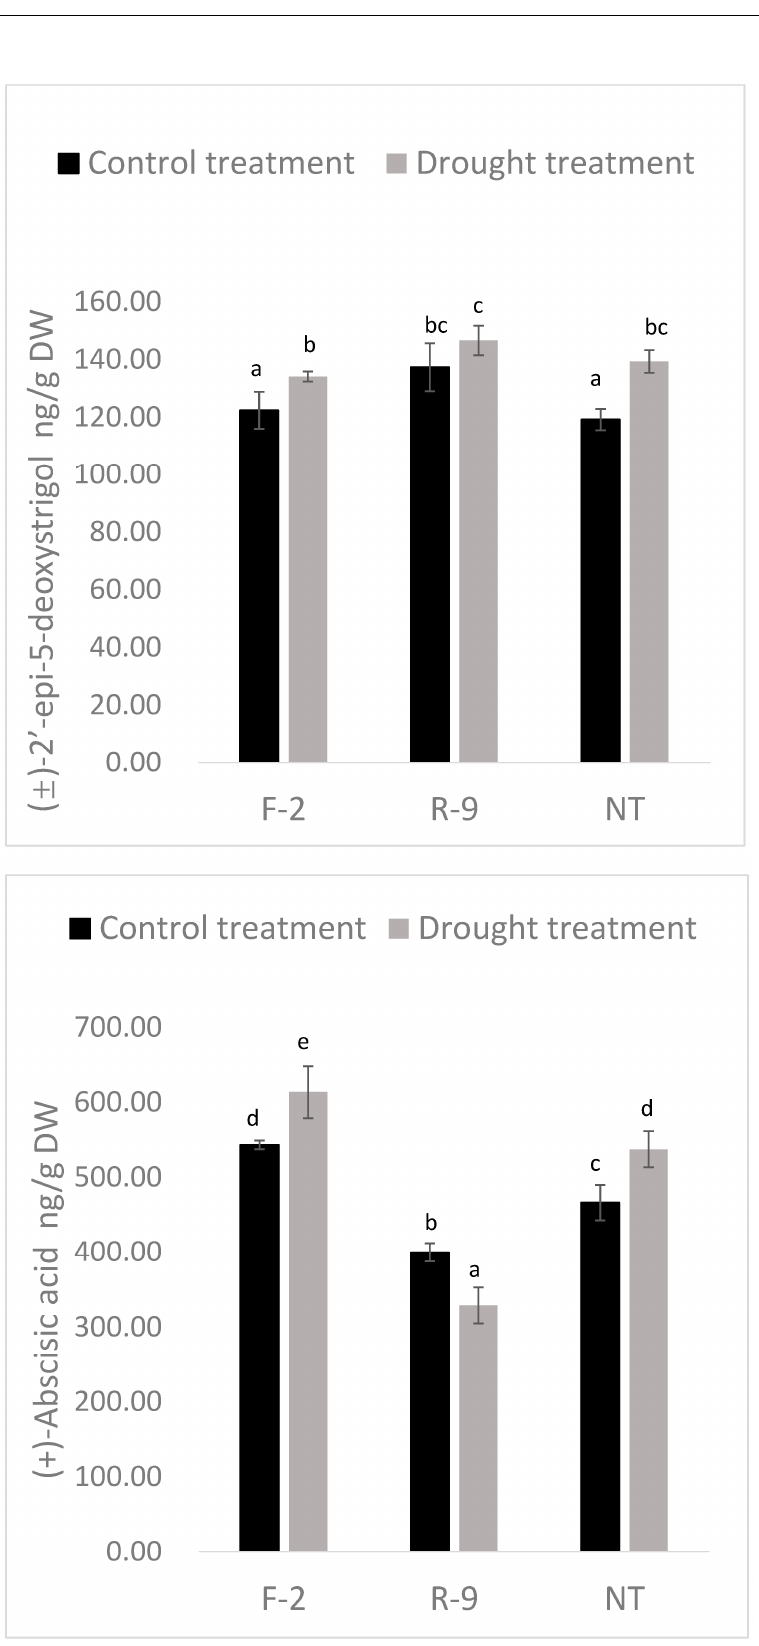
Figure 11. Content of (±)-2 ′ -epi-5-deoxystrigol and (+)-abscisic acid in the rooting culture medium of ScD27.2F-2 and ScD27.2R-9 transgenic lines and NT non-transgenic lines after 30 days of drought stress treatment. Different lowercase letters indicate significant differences at the 0.05 level. The error line represents the standard error ( n =